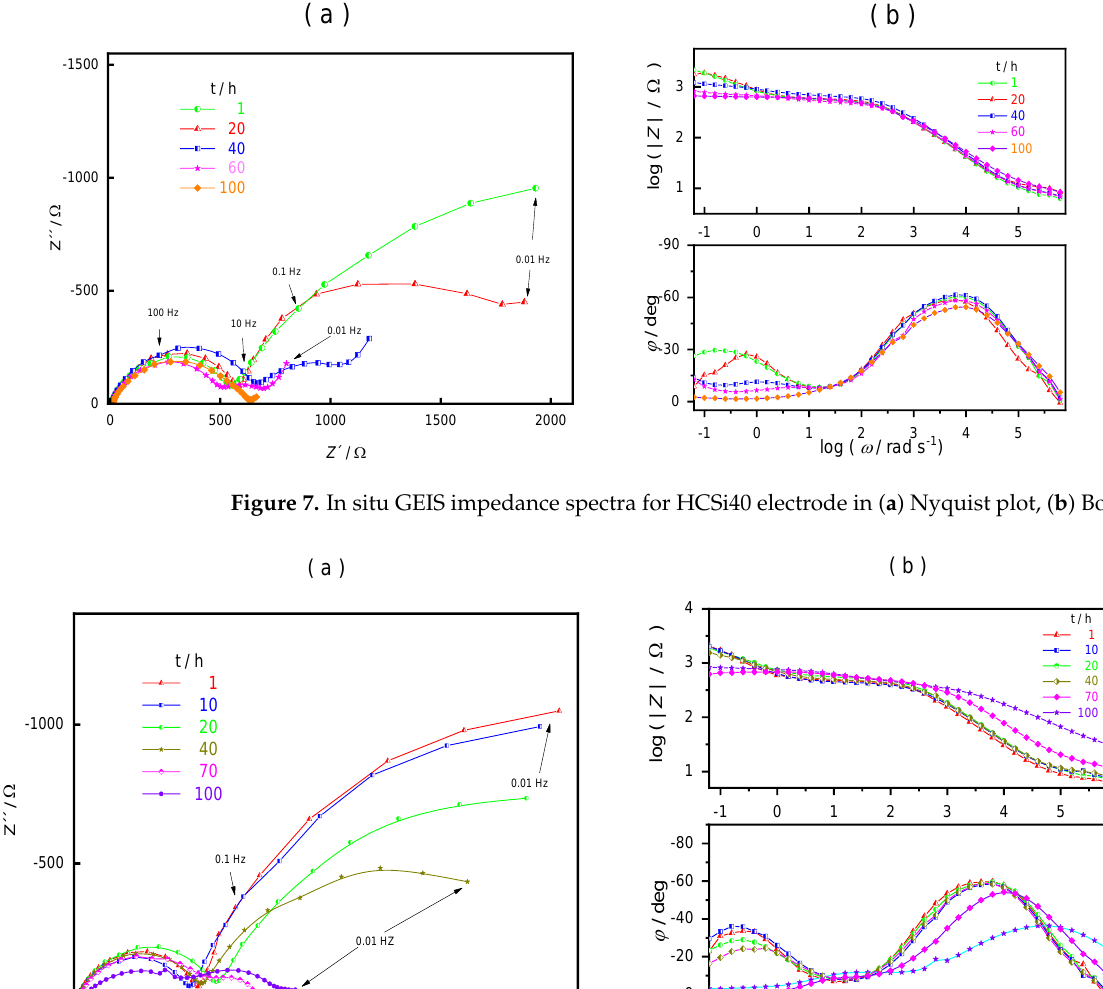
Figure 8. In situ GEIS impedance spectra for HCSi60 electrode in ( a ) Nyquist plot, ( b ) Bode plot.